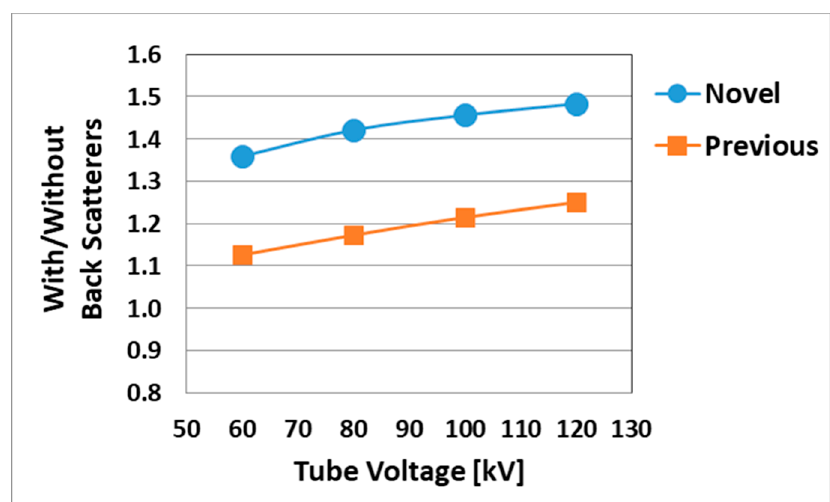
Figure 10. Comparison of with and without scatterers in the novel and previous sensors.